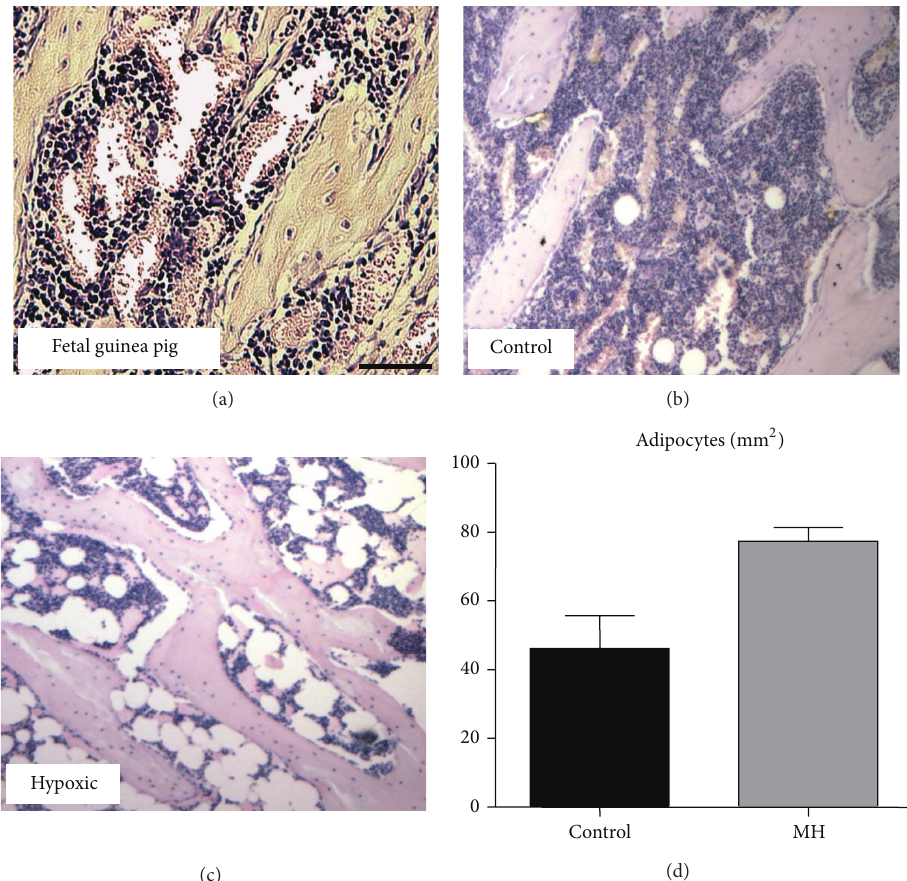
Figure 5: Effects of MH on numbers of adipocytes in the lower secondary spongiosa of tibial bone. (a) Bone marrow in fetal guinea pigs does not contain adipocytes (a section from a control fetal guinea pig). Bone marrow showing presence of adipocytes in a day 120 postnatal guinea pig from a control (b) and a hypoxic mother (c). (d) Bone marrow adipocytes/mm 2 marrow area from control and hypoxia-treated mothers. 𝑛 = 5 . Scale bar in (a) = 500 𝜇 m and applies to (b) and